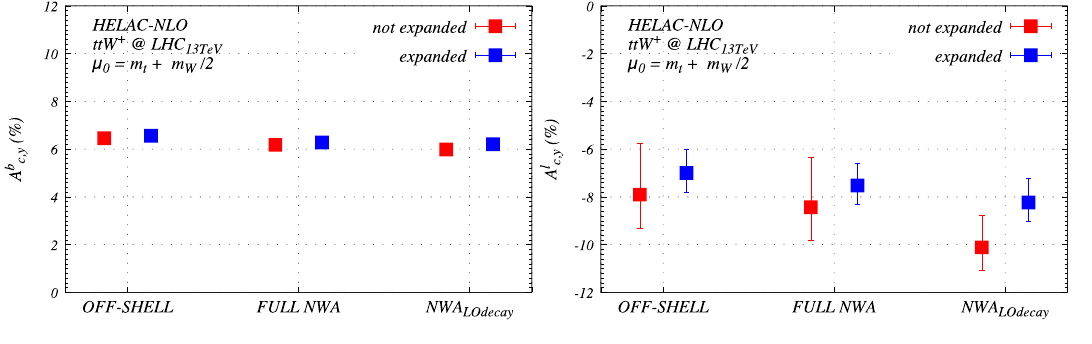
Fig. 6 As in Fig. 5 but for A b c and A (cid:4) c Table 5 As in Table 3 but for μ 0 = H T / 3